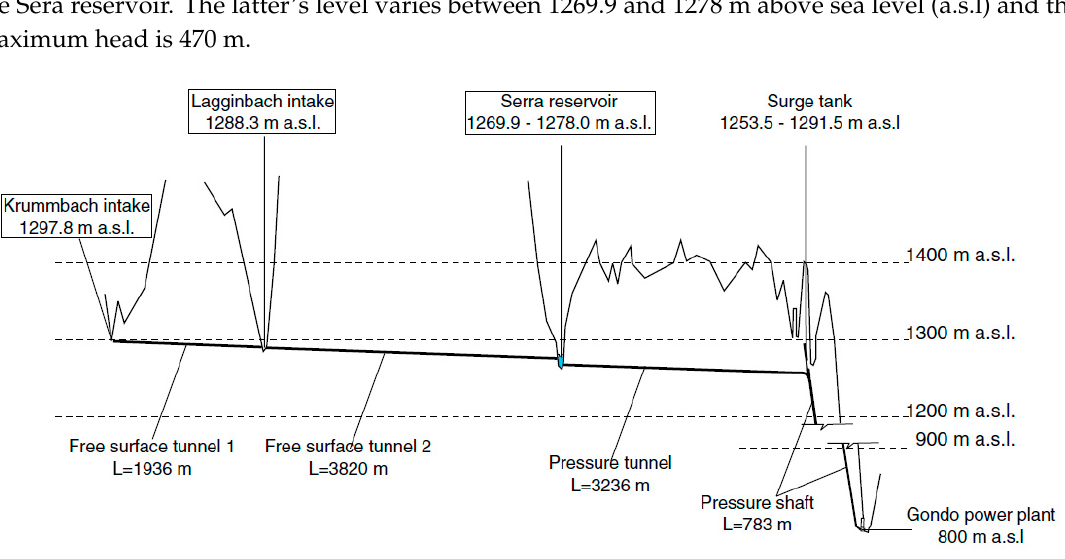
Figure 1. Sketch of the waterway and the hydroelectric power plant [2] .